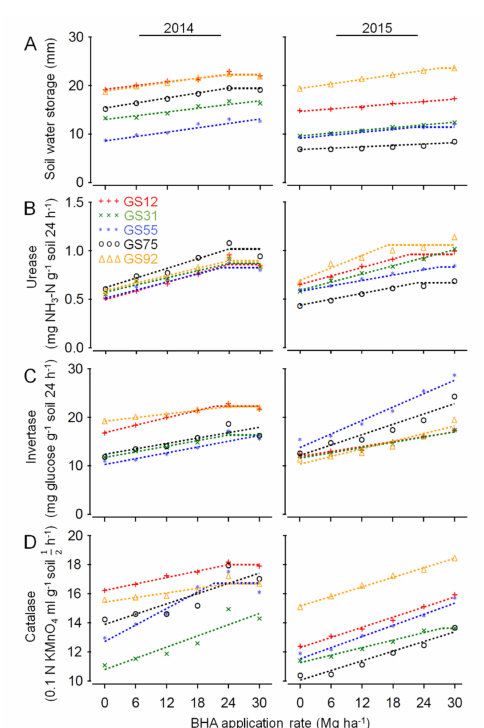
* Slopes of the regression lines were significant ( p < 0.05) for all parameters. Units of intercept are the units of the corresponding dependent variable; units of slope are quotient of dependent variable and rate of BHA; units of